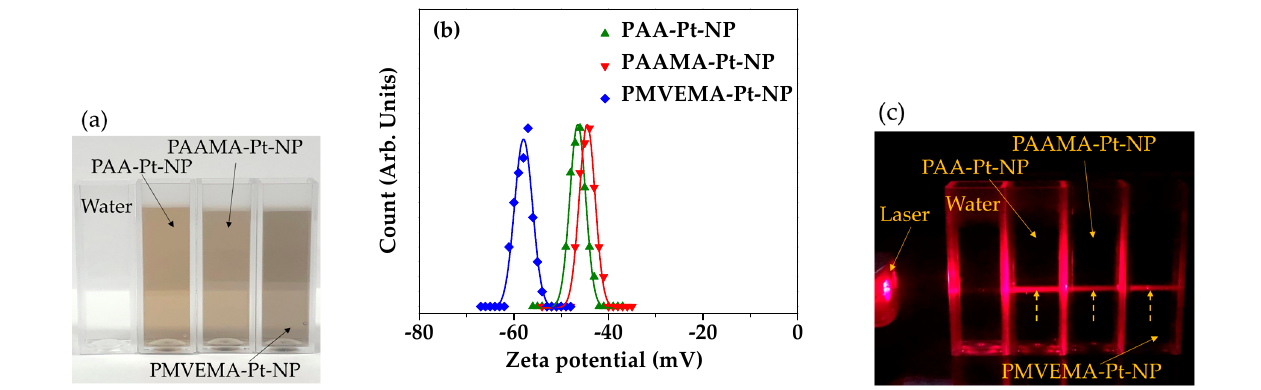
Figure 3. ( a ) Photographs of the diluted NP solution samples, showing no NP precipitation after synthesis for >1.5 years. ( b ) Zeta potential curves of the diluted NP solution samples and Gaussian function fi ts to obtain ζ avg . ( c ) Laser light sca tt ering (indicated with do tt ed arrows) due to laser light collision with NP colloids in aqueous media, showing good colloidal dispersions, whereas no laser light sca tt ering was observed for the vial containing triple-distilled water.